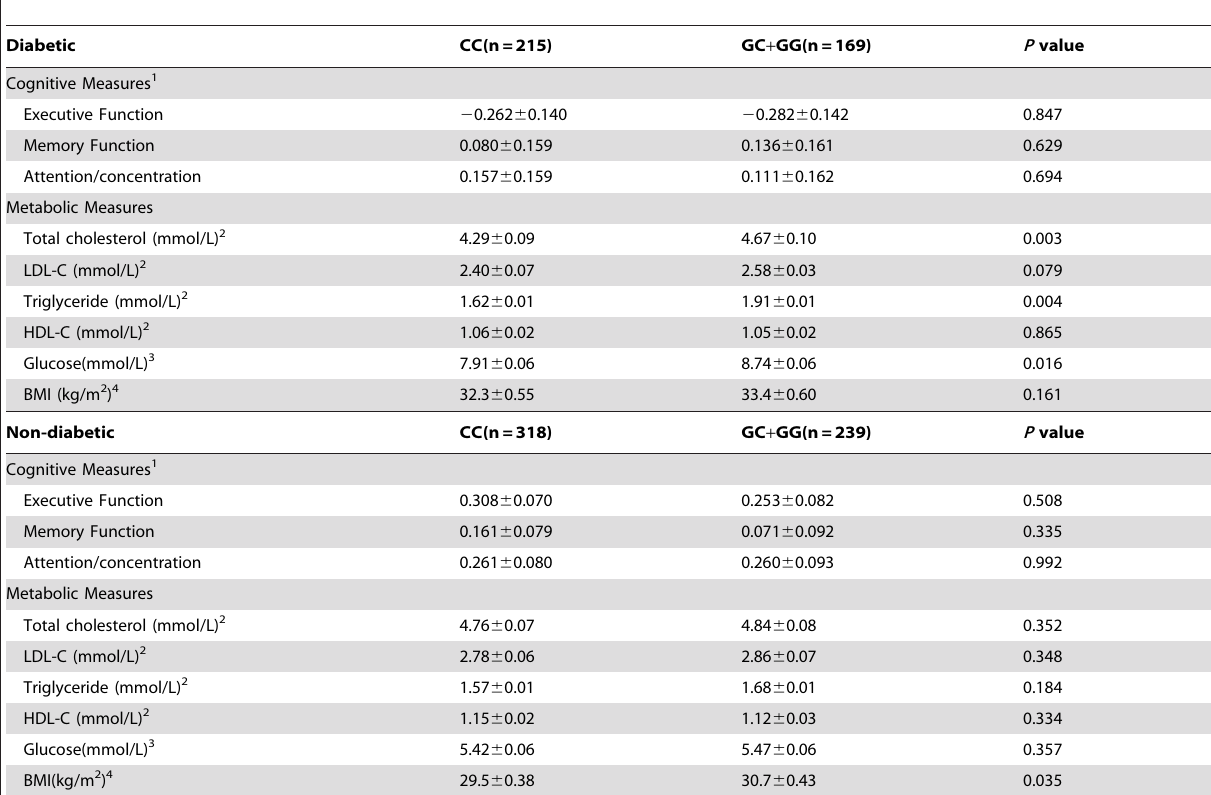
Table 3. Cognitive and metabolic measures for APOC3 3u386 in Caribbean